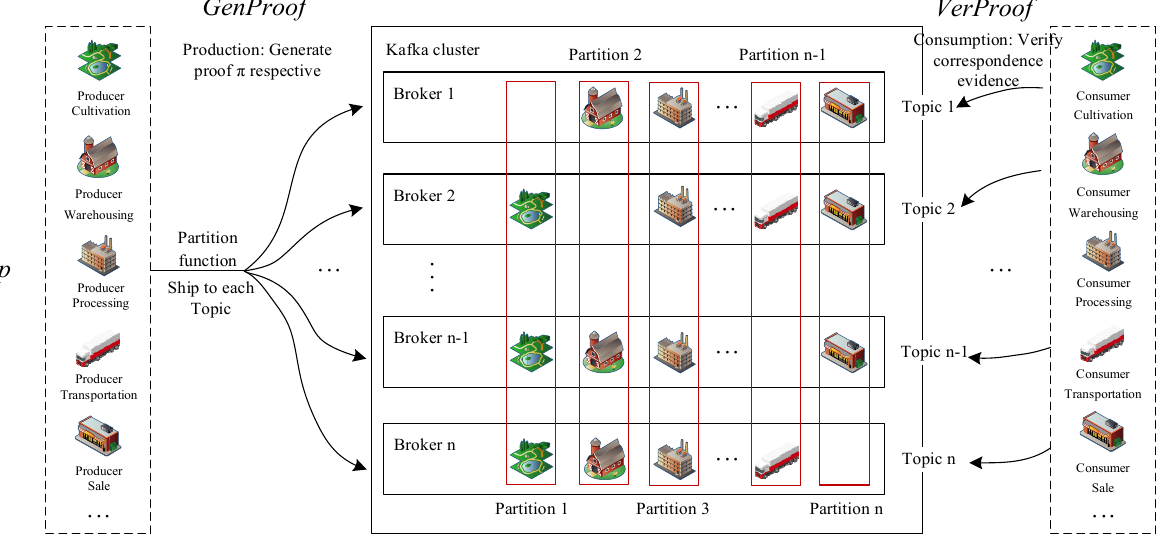
Figure 7. Consensus process of KZKP.